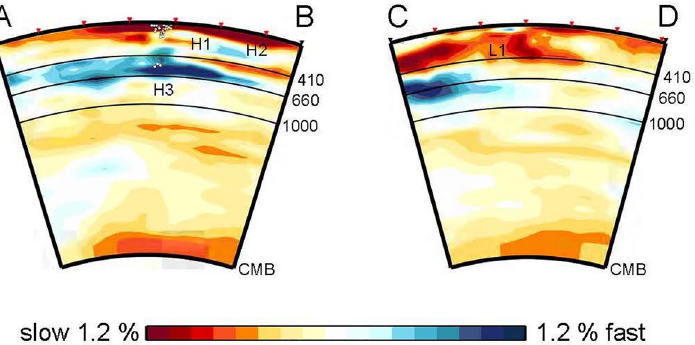
Figure 3. Vertical sections of P-wave velocity anomalies from surface to the core–mantle boundary along the lines AB and CD in Fig. 1. White dots represent hypocenters 54 within a band that is 50 km wide on both sides of the section plane. Tics are added on the upper frame of each cross section at every 5° from the left hand side. H– H3 and L1 indicate the same anomalous regions in Fig.